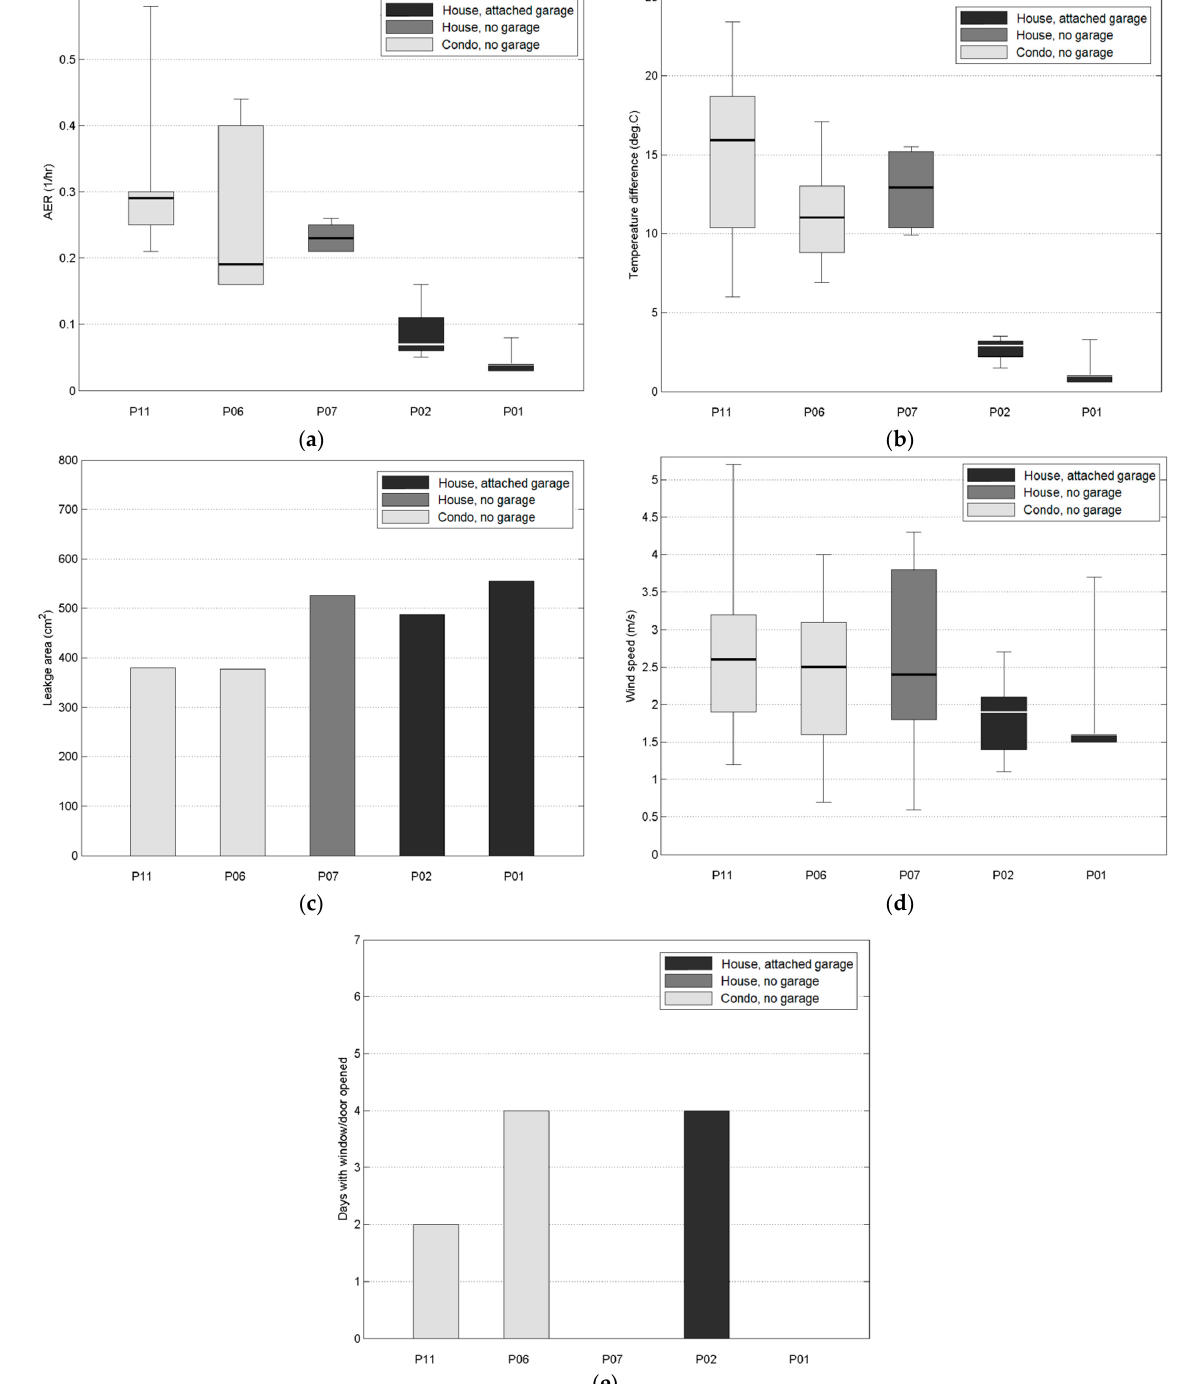
Figure 3. Comparison of ( a ) daily average estimated AERs; ( b ) temperature difference; ( c ) house leakage area; ( d ) wind speed; and ( e ) number of days when windows or doors were open. Note: boxes indicate 25-75 percentiles, horizontal lines are medians, whiskers are minimum and maximum values.